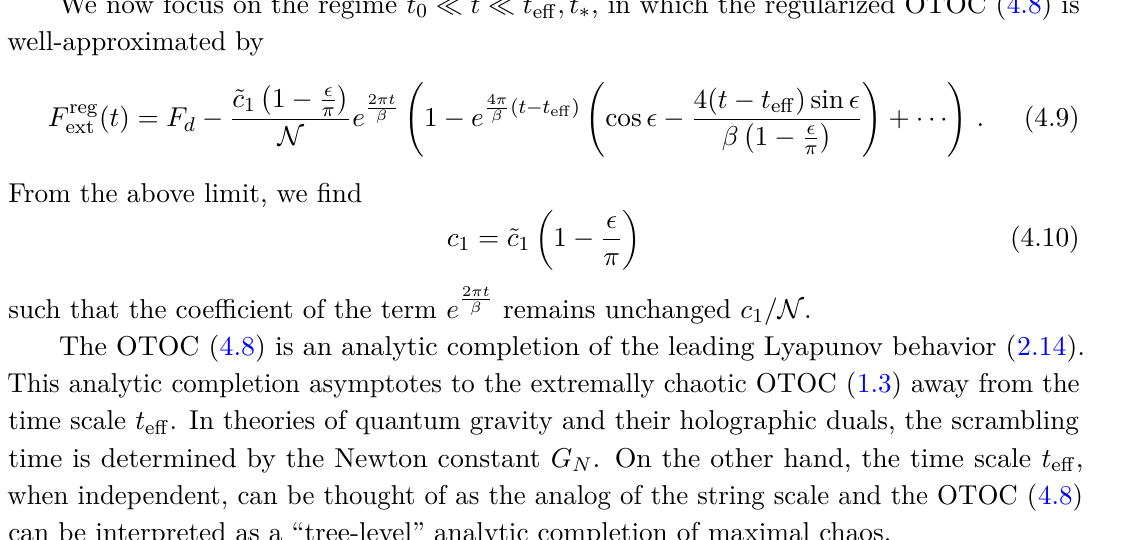
Figure 5 . The regularized density functions (a) and the associated OTOCs (b) are shown for various values of (cid:15) . For the plot, we have chosen β = 2 π, F this set of parameters, the bound (4.7) requires that (cid:15) ≥ 0 . 1415 . The dashed black lines represent the unregularized OTOC (1.3). The regularized OTOC differs only slightly from the unregularized OTOC even when (cid:15) = 1